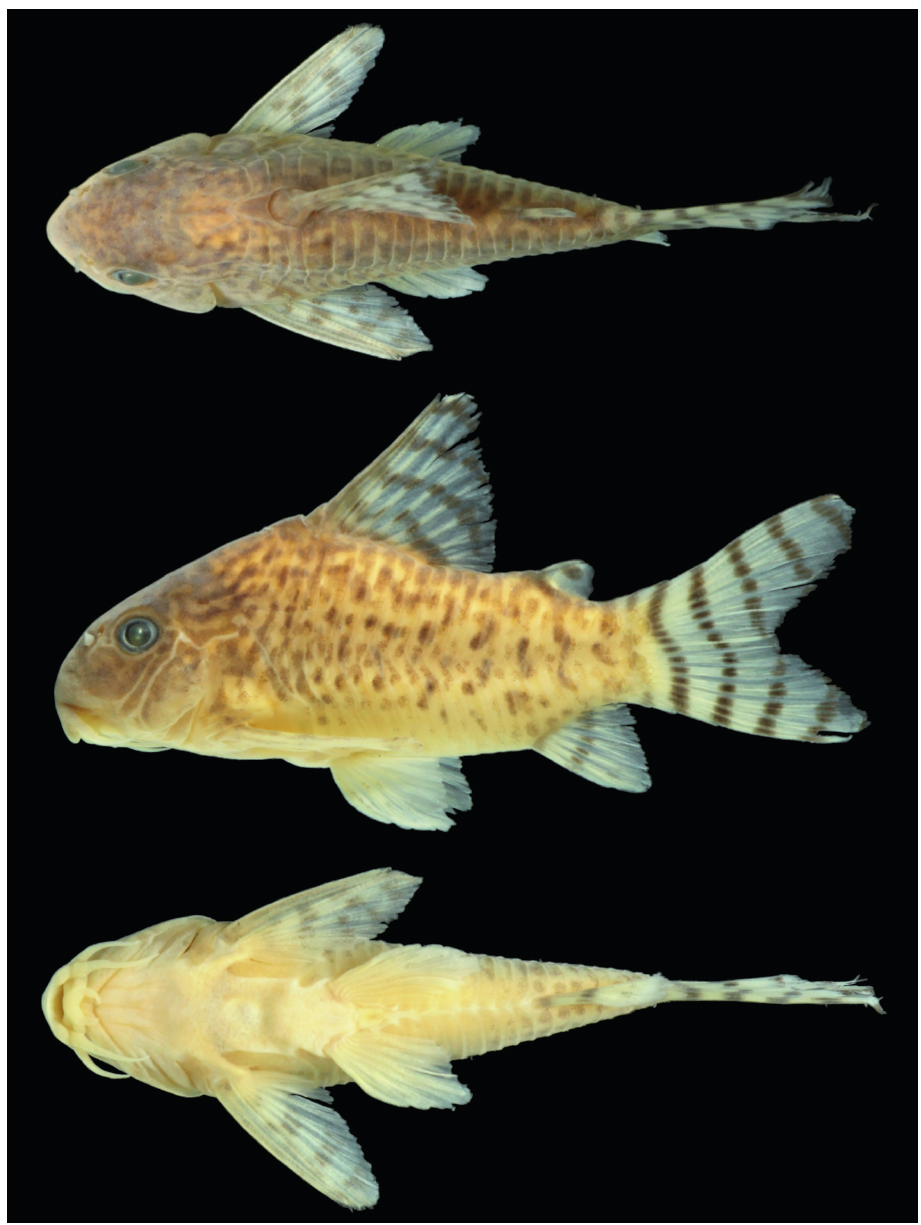
FIGURE 1 | Corydoras thanatos , holotype, MNRJ 53287, 33.2 mm SL, Novo Progresso Municipality, Pará State, Brazil, stream with unknown name tributary to the rio Jamanxim, rio Tapajós